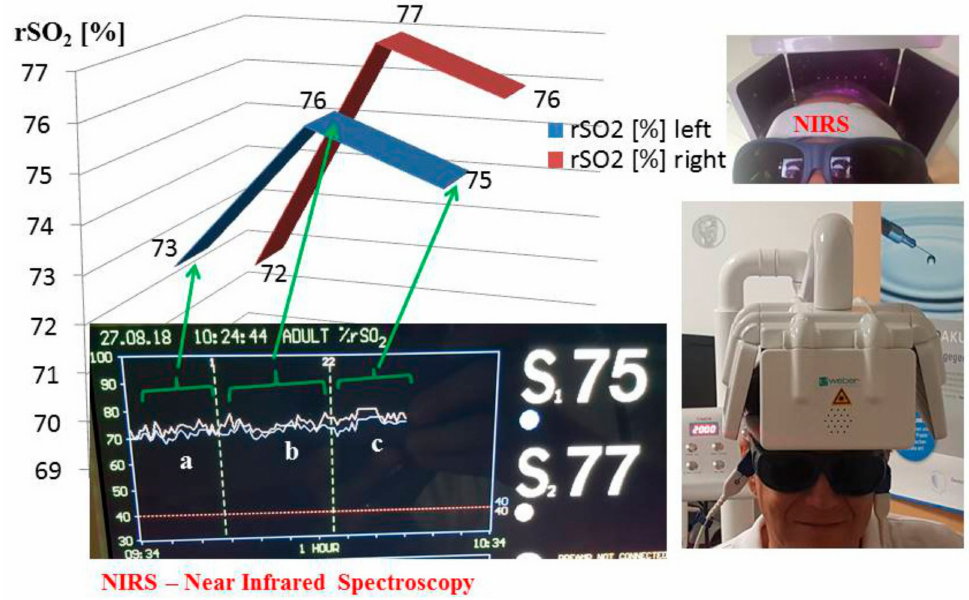
Figure 2. Results of the first pilot measurement of the new transcranial laser stimulation